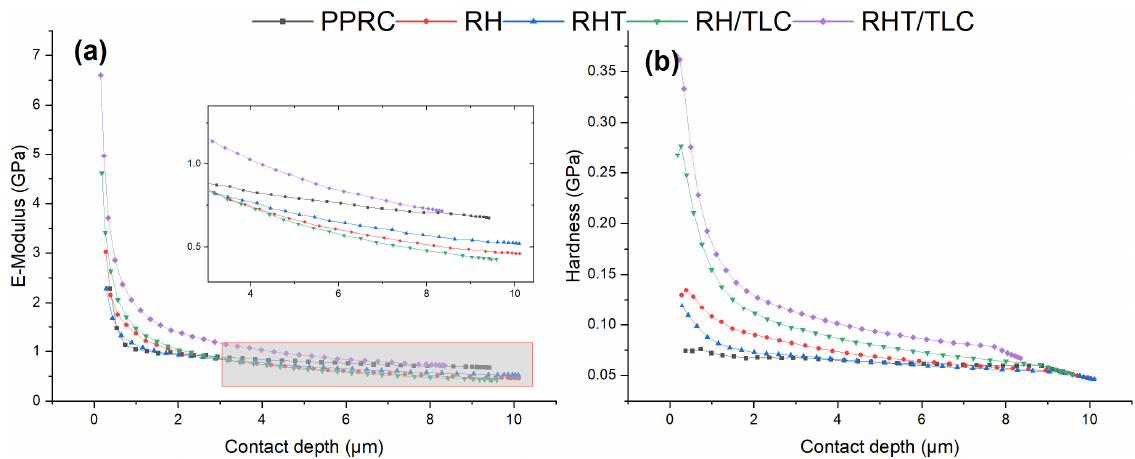
Figure 6. ( a ) Elastic modulus profile as a function of depth. ( b ) Hardness profile as a function of